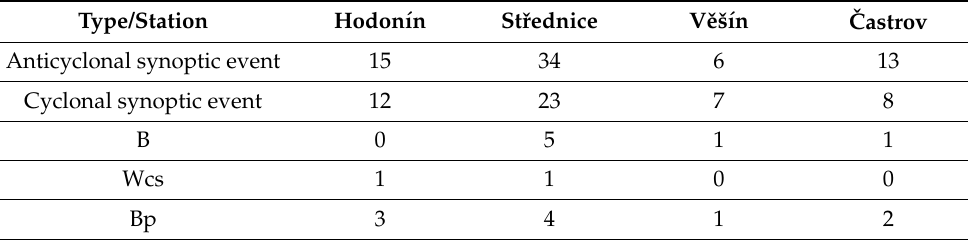
Table 8. Frequency of synoptic event occurrence in the period of the cherry tree flowering during days with T min < − 1.1 ◦ C (period of